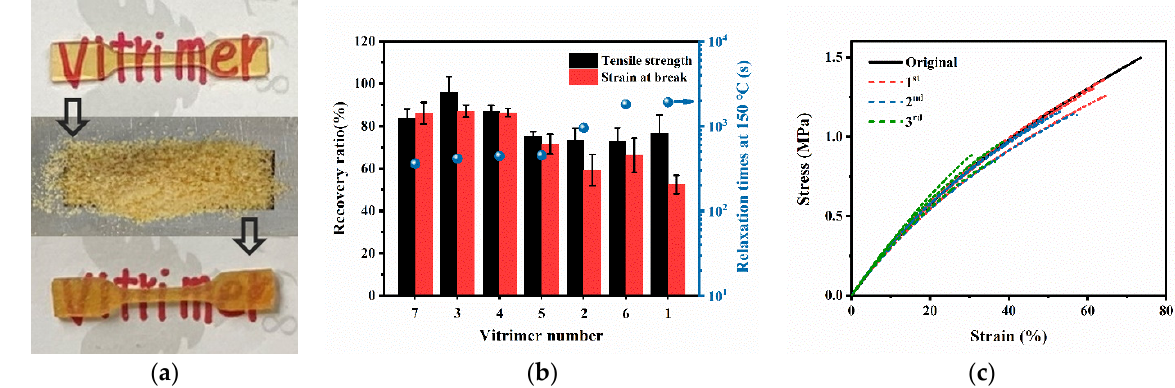
Figure 12. ( a ) Recycling schematic of PB vitrimers; ( b ) recovery ratios of mechanical properties for PB vitrimers after recycling; ( c ) stress–strain curves of original and recycled vitrimer